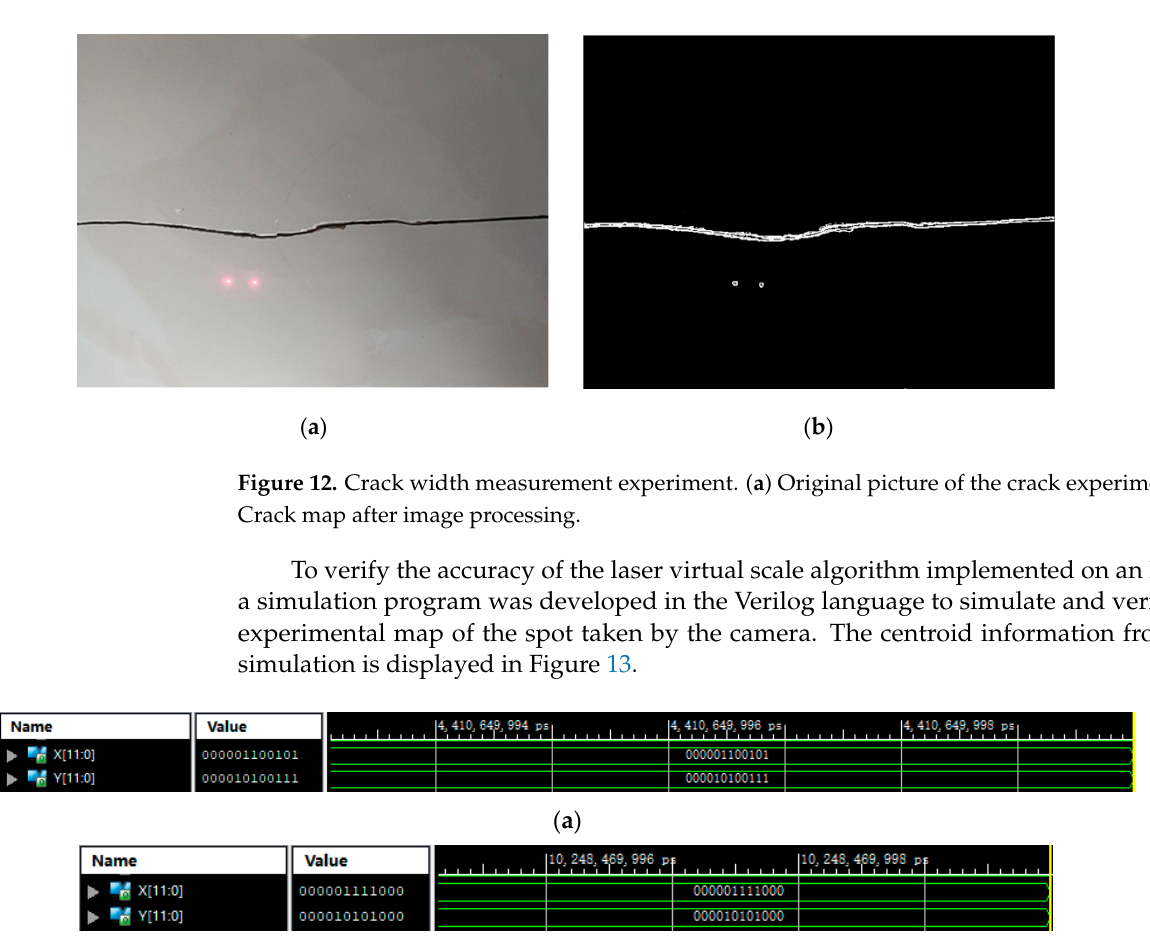
Figure 13. Simulation results of centroid coordinates.